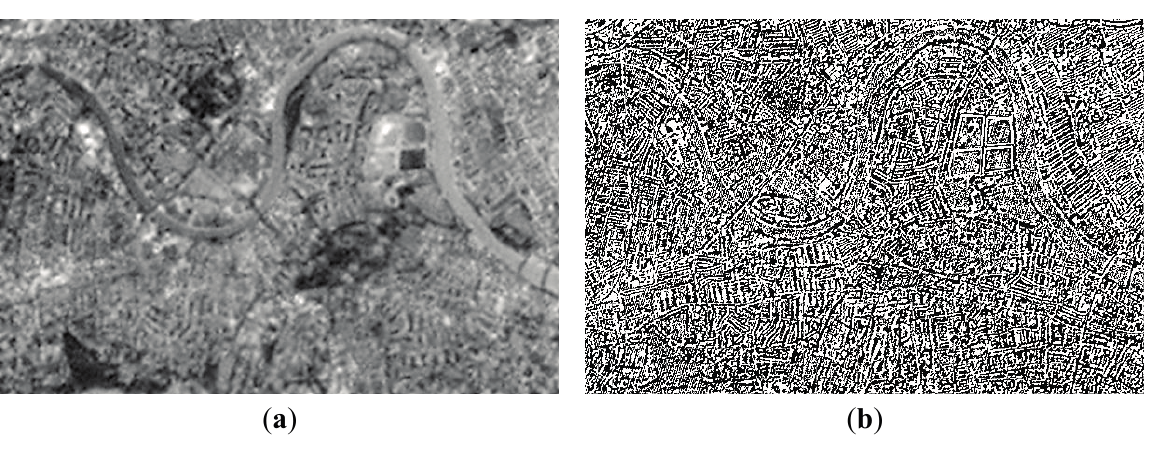
Figure 6. ( a ) The LP with highest correlation with V. ( b ) The corresponding HP with obtained